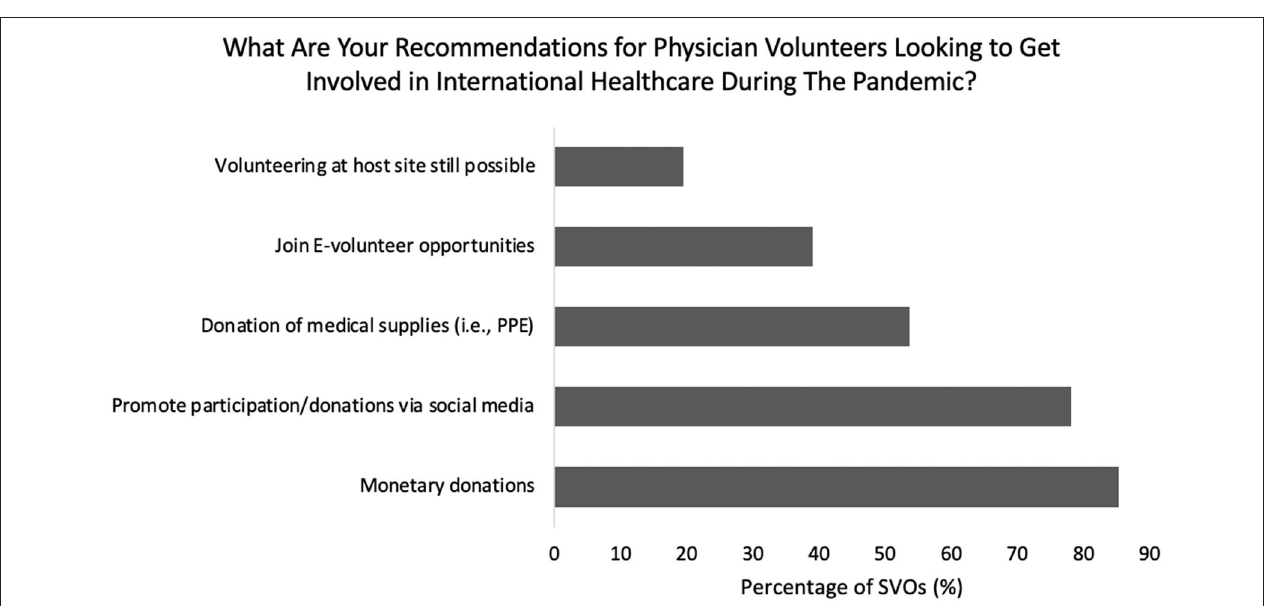
FIGURE 5 | Breakdown of recommendations for physician volunteers during the pandemic.